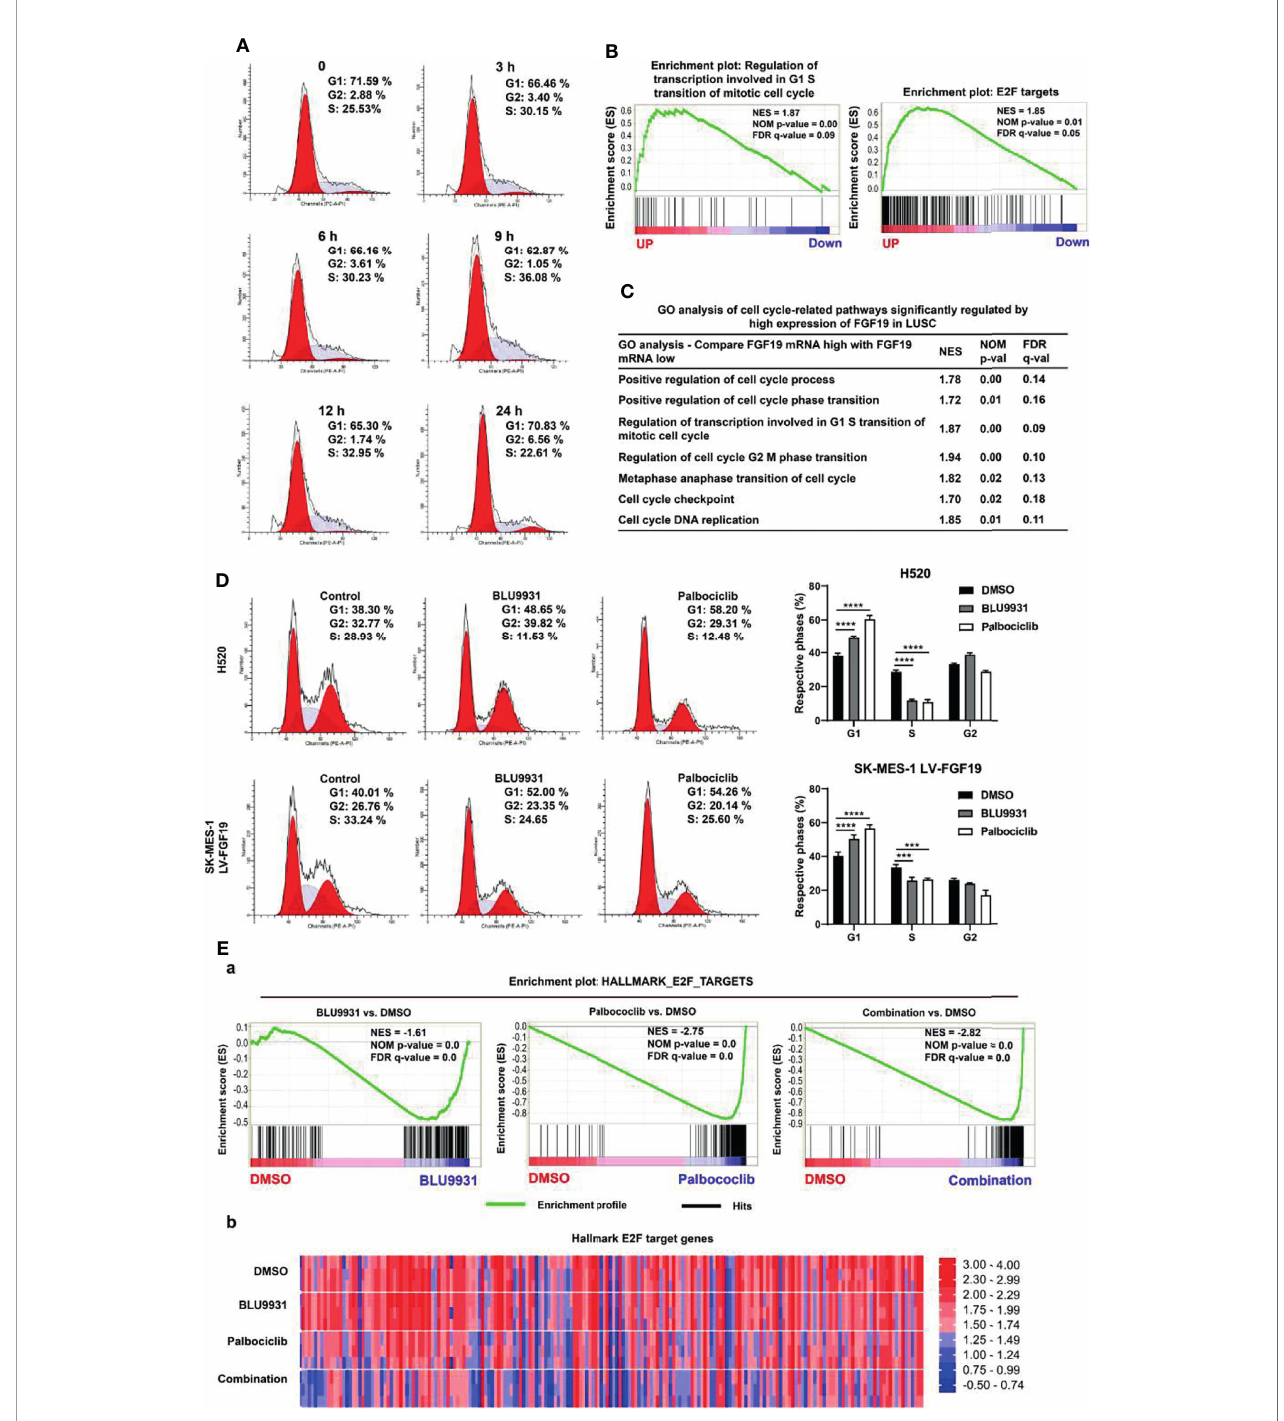
FIGURE 4 | FGF19 combined with CCND1 promotes cellcycleprogression. (A) rhFGF19 promoted the cellcycleof LUSC cells fromG1 to S phase. (B) Enrichment plots of regulation of transcription involved in G1/S transition of mitotic cell cycle and E2F targets signatures according to FGF19 expression levels in an LUSC cohort. (C) GO analysis of cell cycle-related pathways signi fi cantly regulated by high expression of FGF19 in LUSC cohort. (D) Representative histograms depicting cell cycle pro fi les of SK-MES-1 LV-FGF19 and H520 cells with or without BLU9931 and palbociclib. Right panel: quanti fi cations of the histograms. (E) H520 was treated with DMSO, 1 m M BLU9931, 1 m M palbociclib or their combination. (a) Enrichment plot showing HALLMARK_E2F_TARGETS signatures and (b) Heatmap showing the expression of common E2F target genes according to the drug treatment. All the data were shown as the mean ± SD. *** p < 0.001; **** p <